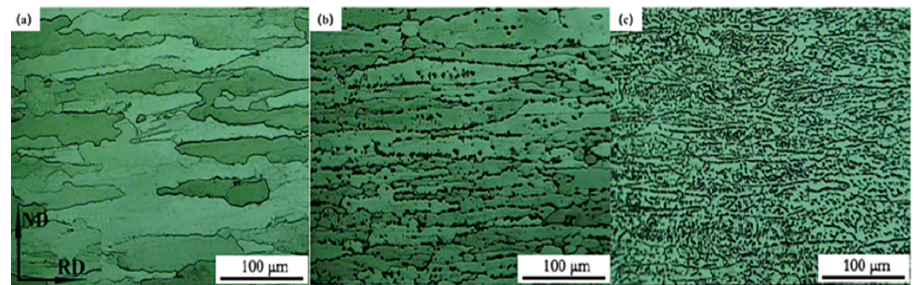
Figure 12. High-strength aluminum alloy samples at ( a ) quenching temperature; ( b ) 405 °C/1 h; ( c ) optical micro-photograph at 340 °C/1 h [68].